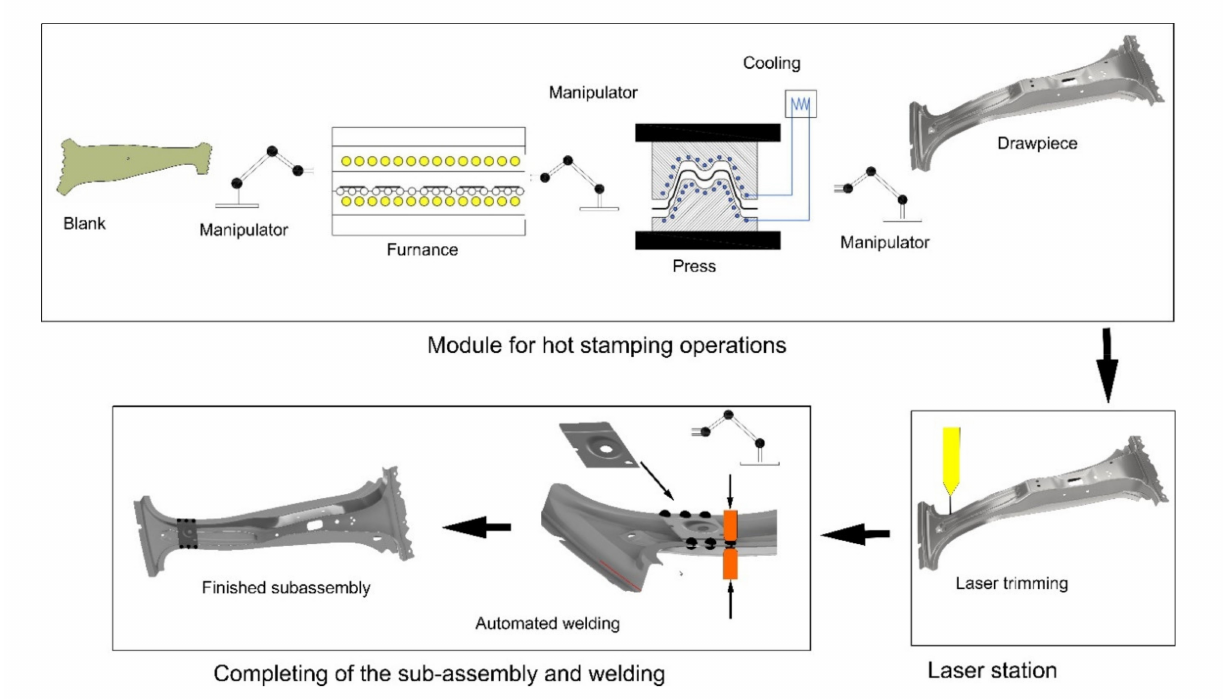
Figure 1. Scheme of the automatic line to production of car body